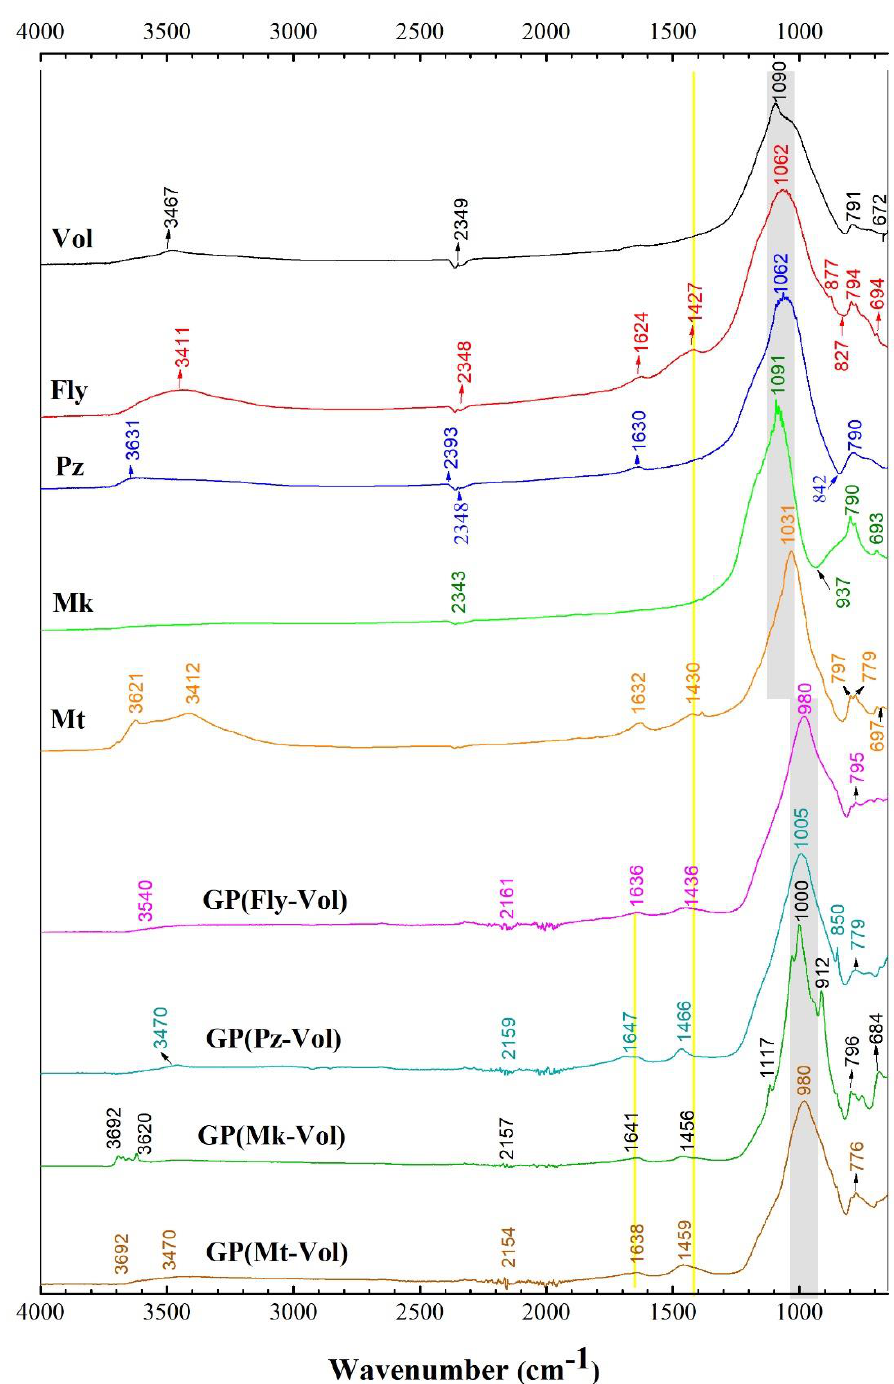
Figure 3. FTIR spectra of geopolymers based on volcanic ash and all raw materials (Fly, Pz, Mk, and Mt).